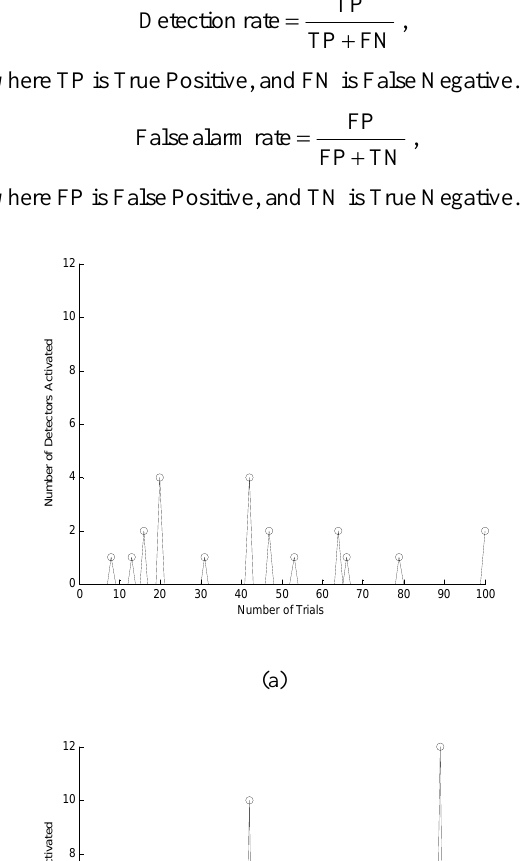
Fig. 11. of feature signals of bearings in Example 3 (a). V (b) of feature signal of faulty bearings with ball damage. V